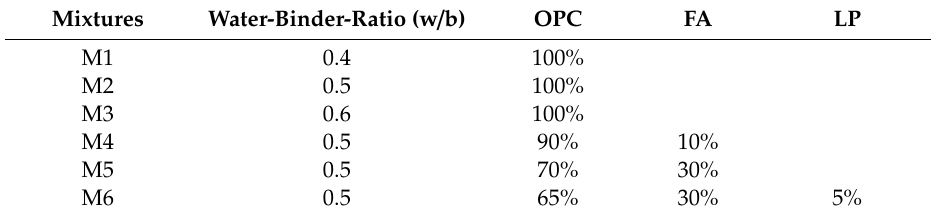
Table 1. Mix proportions of paste samples (weight percentage) with ordinary Portland cement (OPC), fly ash (FA) and limestone powder